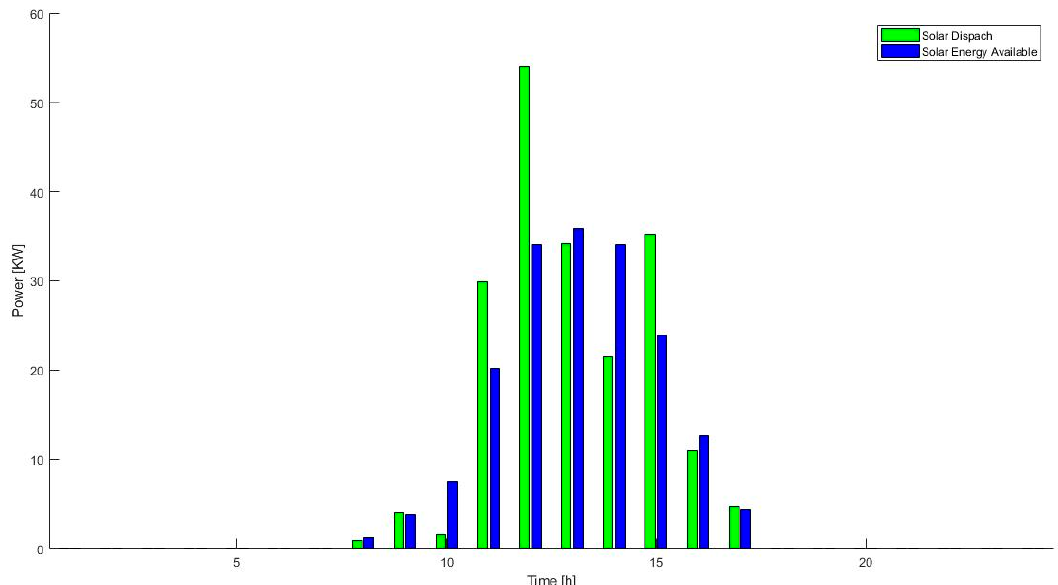
Figure 8. Availability and dispatch of the solar energy system of the MG when the storage system is after the 60% of its useful life.